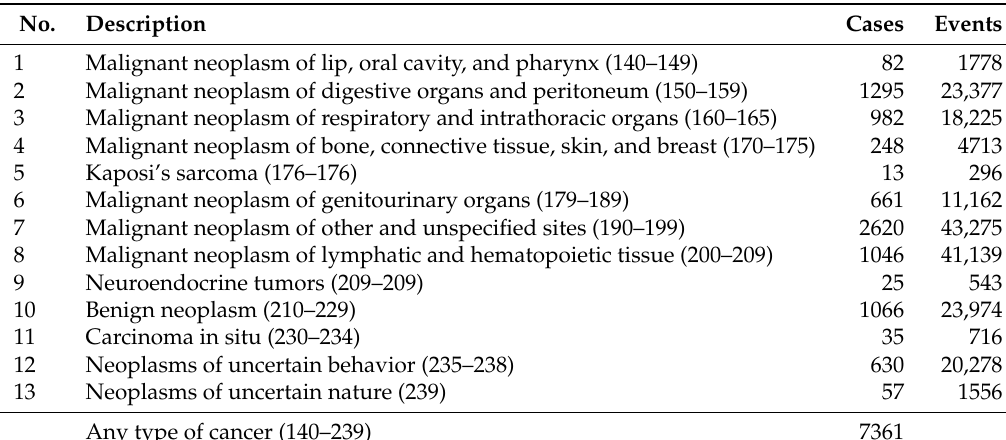
Table 1. Patients with different cancer types. Patients can have multiple types of cancers. Bottom row